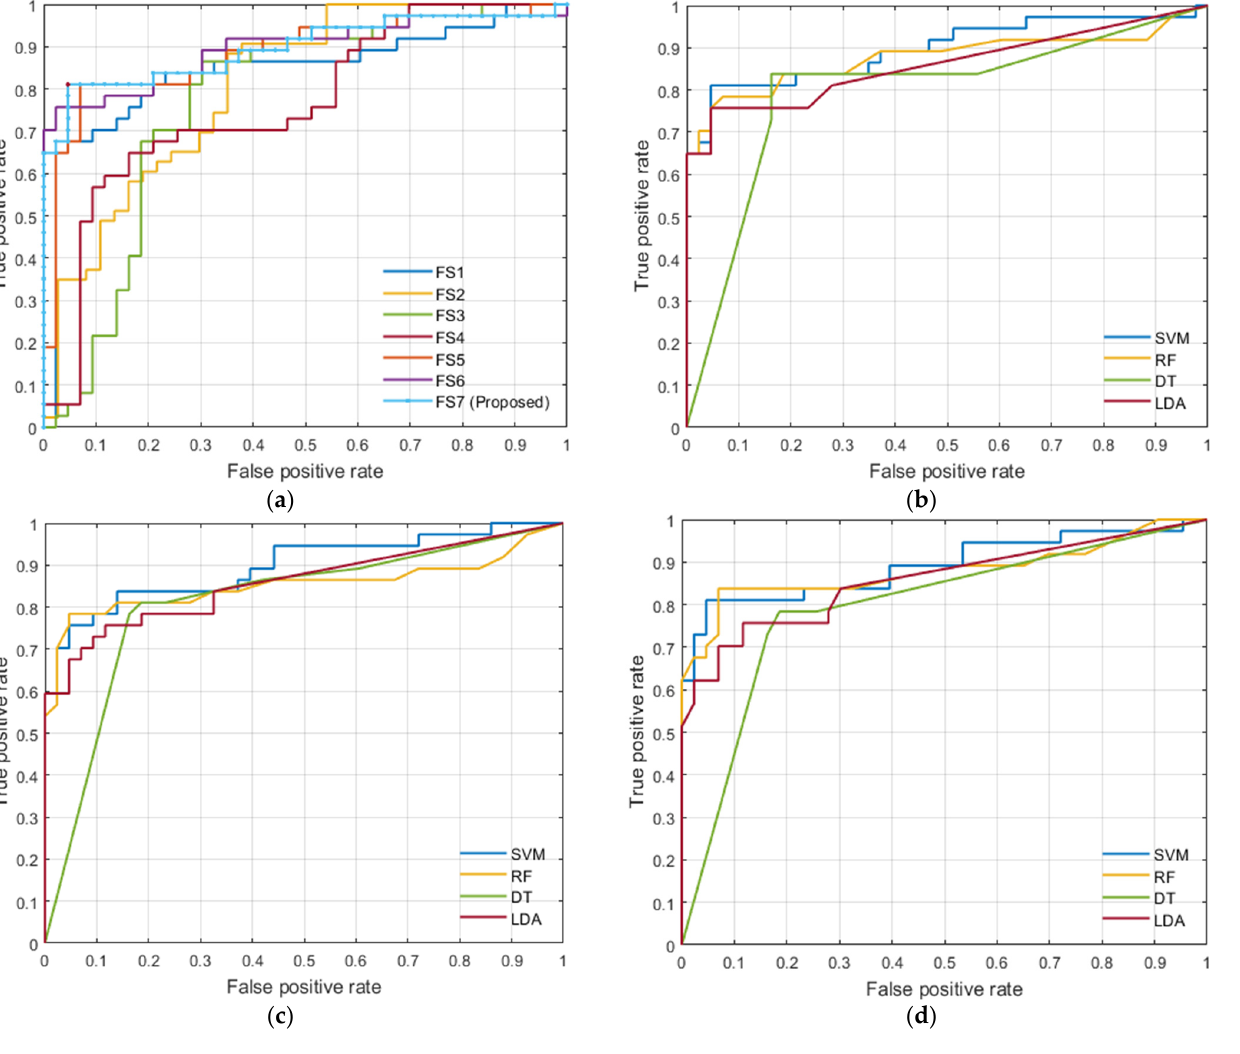
Figure 11. ROC curves of ( a ) SVM comparing various feature sets using leave-one-out cross validation, ( b ) different classifiers comparison using FS7 along with leave-one-out cross validation, ( c ) different classifiers comparison using FS7 along with 5-fold cross validation, and ( d ) comparison of classifiers using FS7 along with 10-fold cross validation.